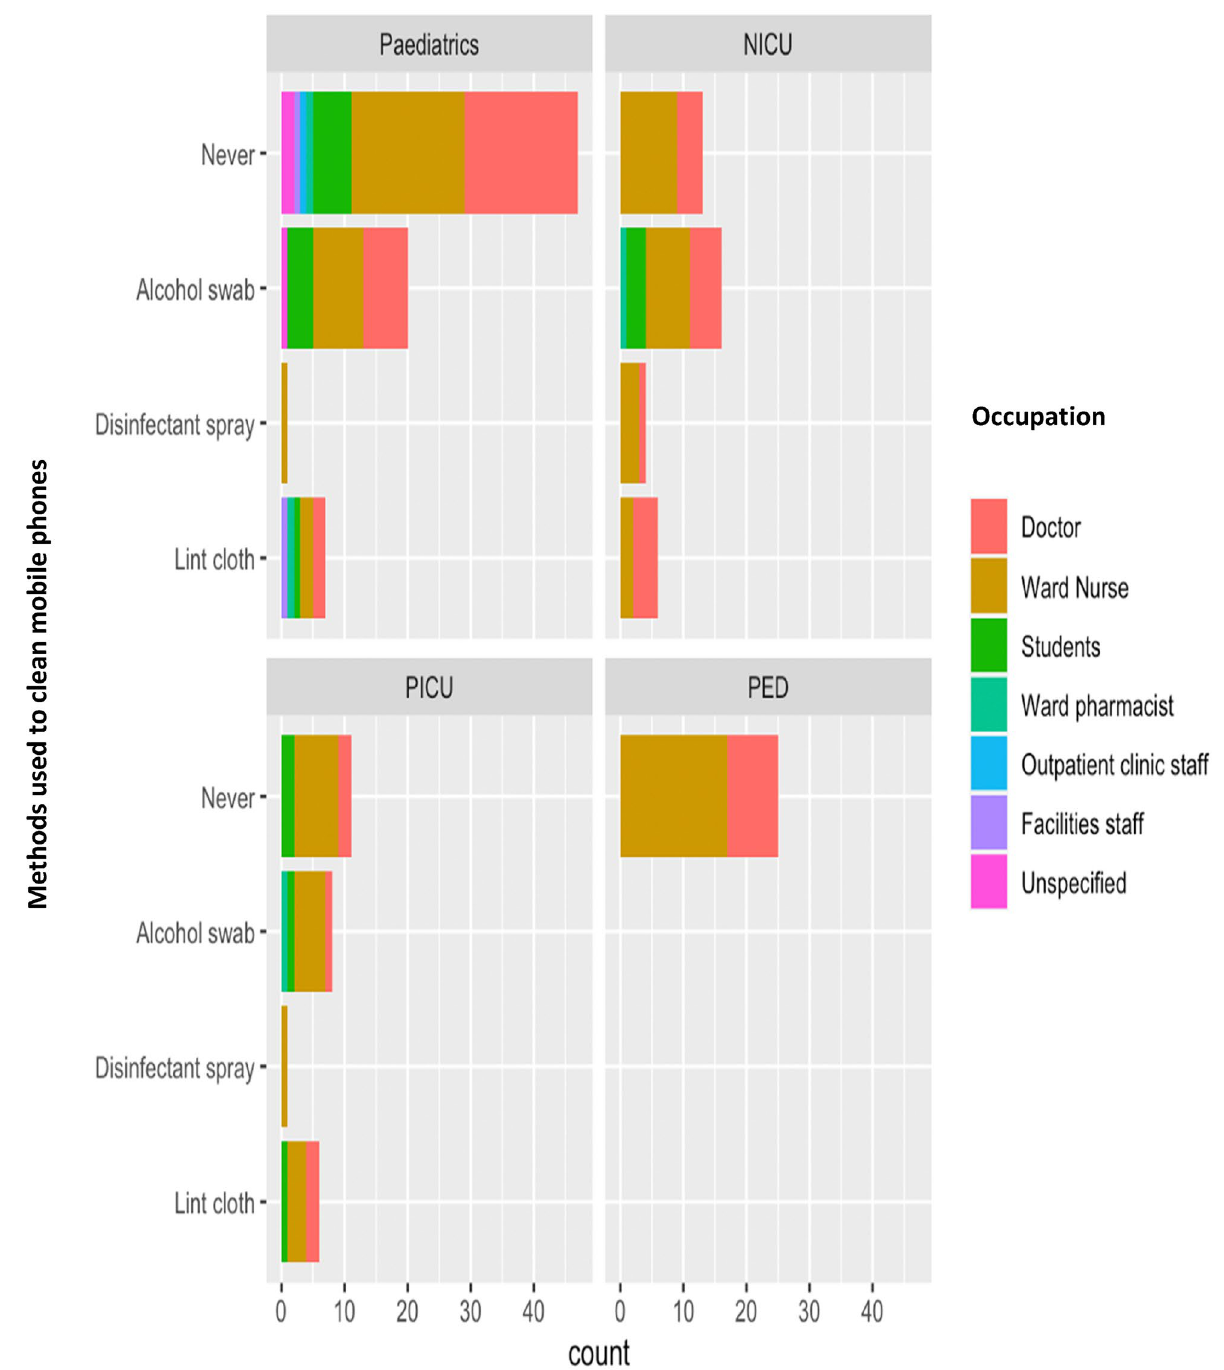
Figure 5. Mobile phone cleaning method and staff role across four different hospital wards (General Paediatrics, Neonatal Intensive Care Unit, Paediatric Intensive Care Unit, Paediatric Emergency